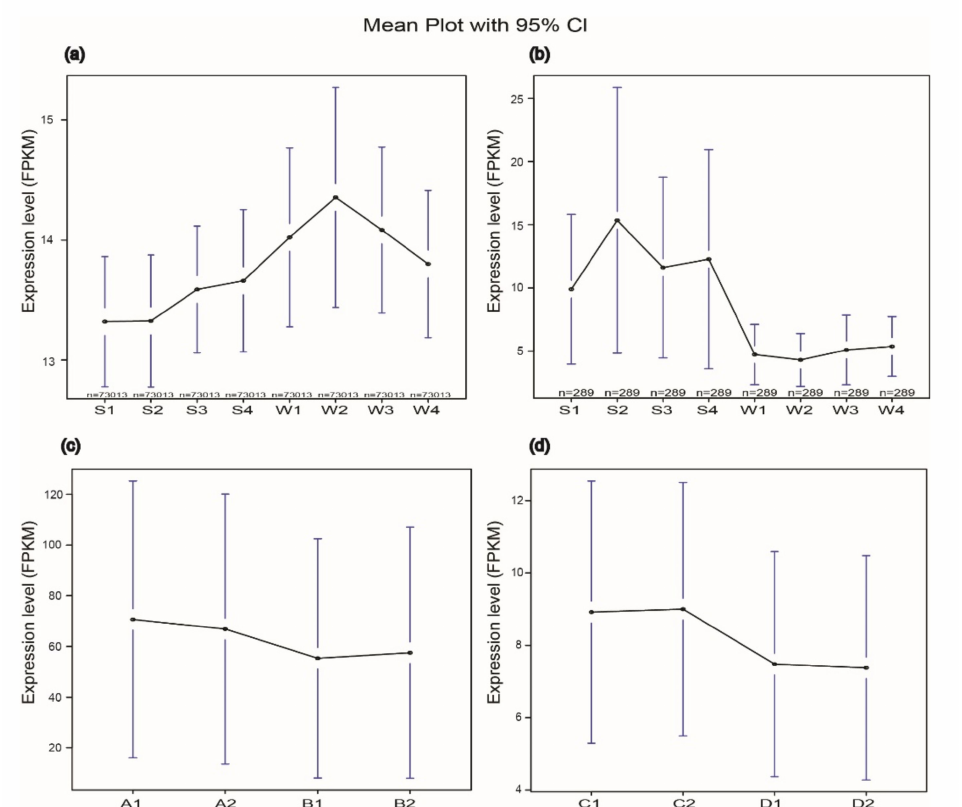
Figure 5. Expression level of Populus genes under salt stress detected by RNA-Seq. The expression is measured as FPKM (fragments per kilo-base transcript per million mapped reads) based on the Illumina HiSeq platform. A1, A2, C1, C2, S1, S2, S3 and S4 were treated with NaCl. B1, B2, D1, D2, W1, W2, W3 and W4 were controls treated with regular water. The overall expression of all the genes in 84K poplar ( a ). The overall expression of NACs in 84K poplar ( b ), P. simonii × P. nigra T. S. Hwang et Liang ( c ) and Arabidopsis thaliana (L.) Heynh. ( d